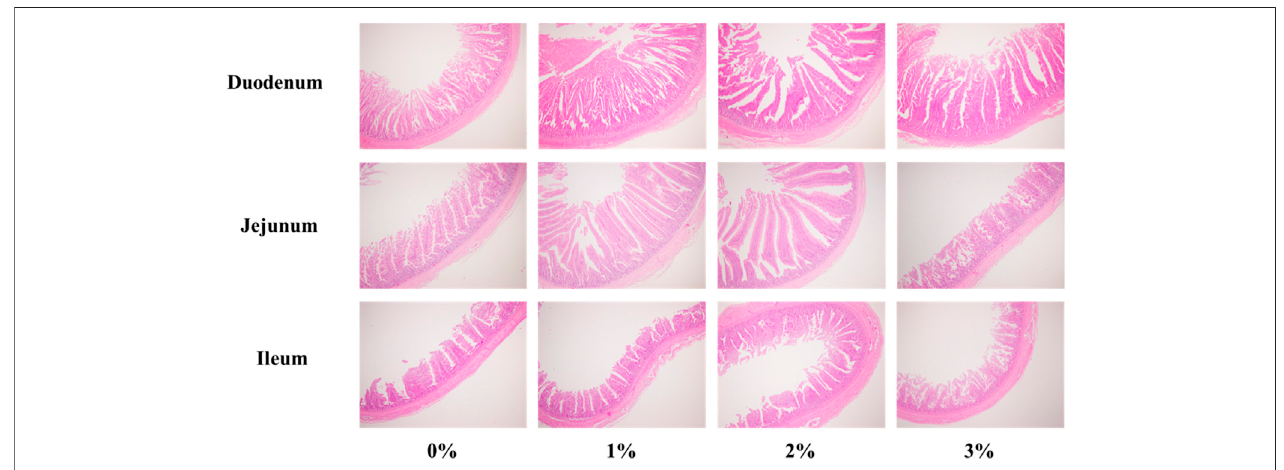
FIGURE 1 | Effects of Artemisia argyi on intestinal morphology of duodenum, jejunum and ileum of Romance laying hens. HE 4 × 10.